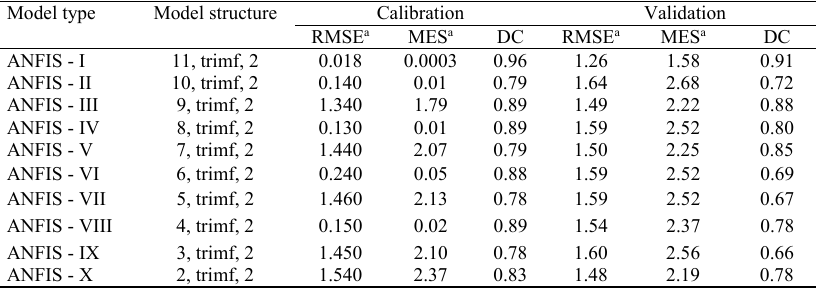
Table 6: Performance efficiency for the three stations in validation